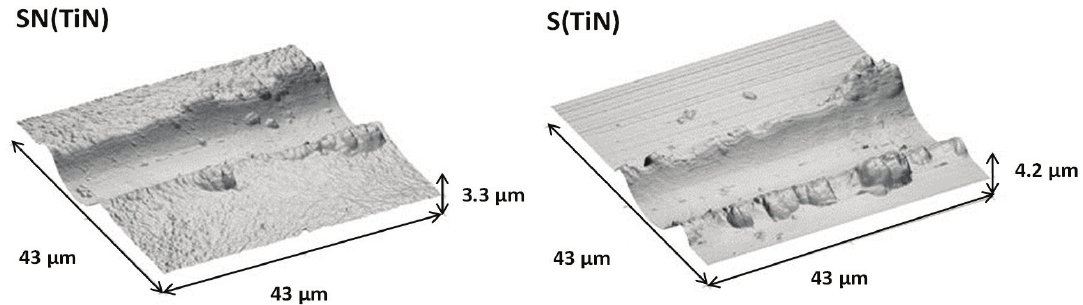
Figure 3. Profiles of surface sample topography by atomic force microscopy.